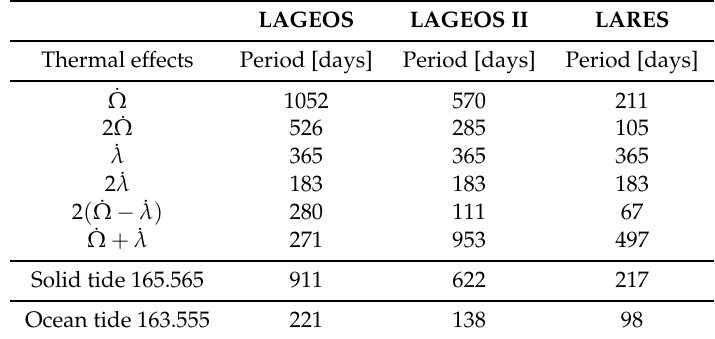
Table 6. Periodic effects on the RAAN of the LAGEOS and LARES satellites. The periods have been rounded to the closest integer number of days (the different phases were not considered). The rate ˙ λ refers to the time variation of ecliptic longitude of the Earth around the Sun. Some of the thermal spectral lines are also common to solid and ocean tides. LAGEOS LAGEOS